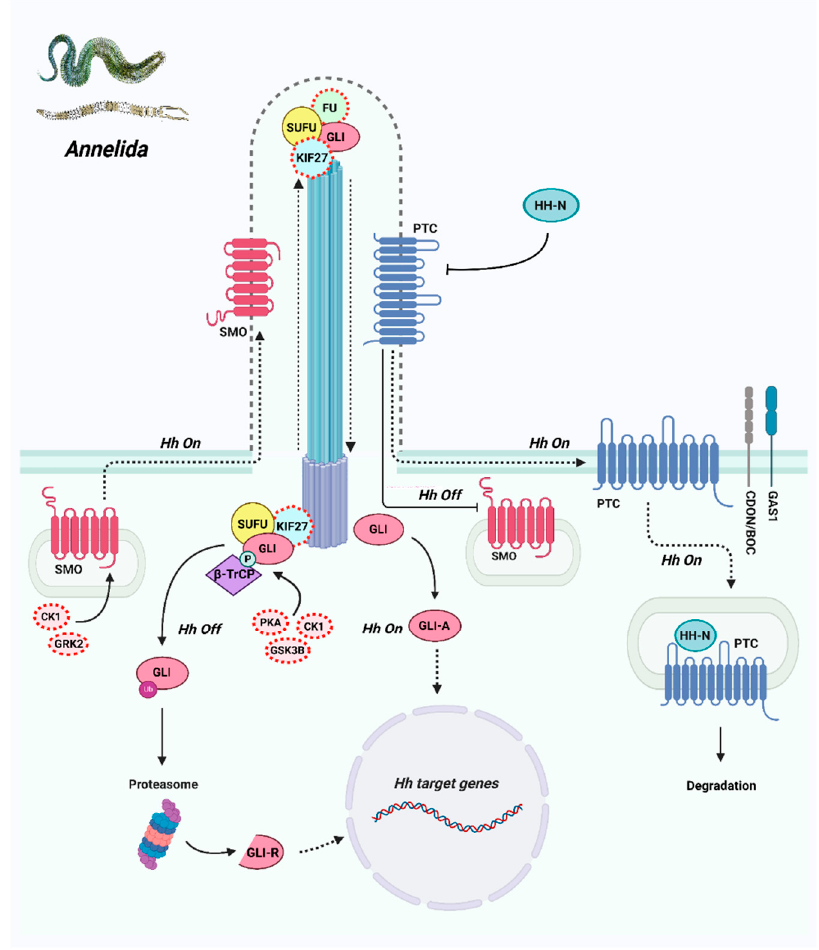
Figure 11. The predicted scheme of the Hedgehog signaling pathway in annelids. The grey dashed line delineates the primary cilium, which may participate in Hh signaling in annelids. The putative signaling participants (compared with these proteins’ functions in other animals) are encircled by red dashed lines.